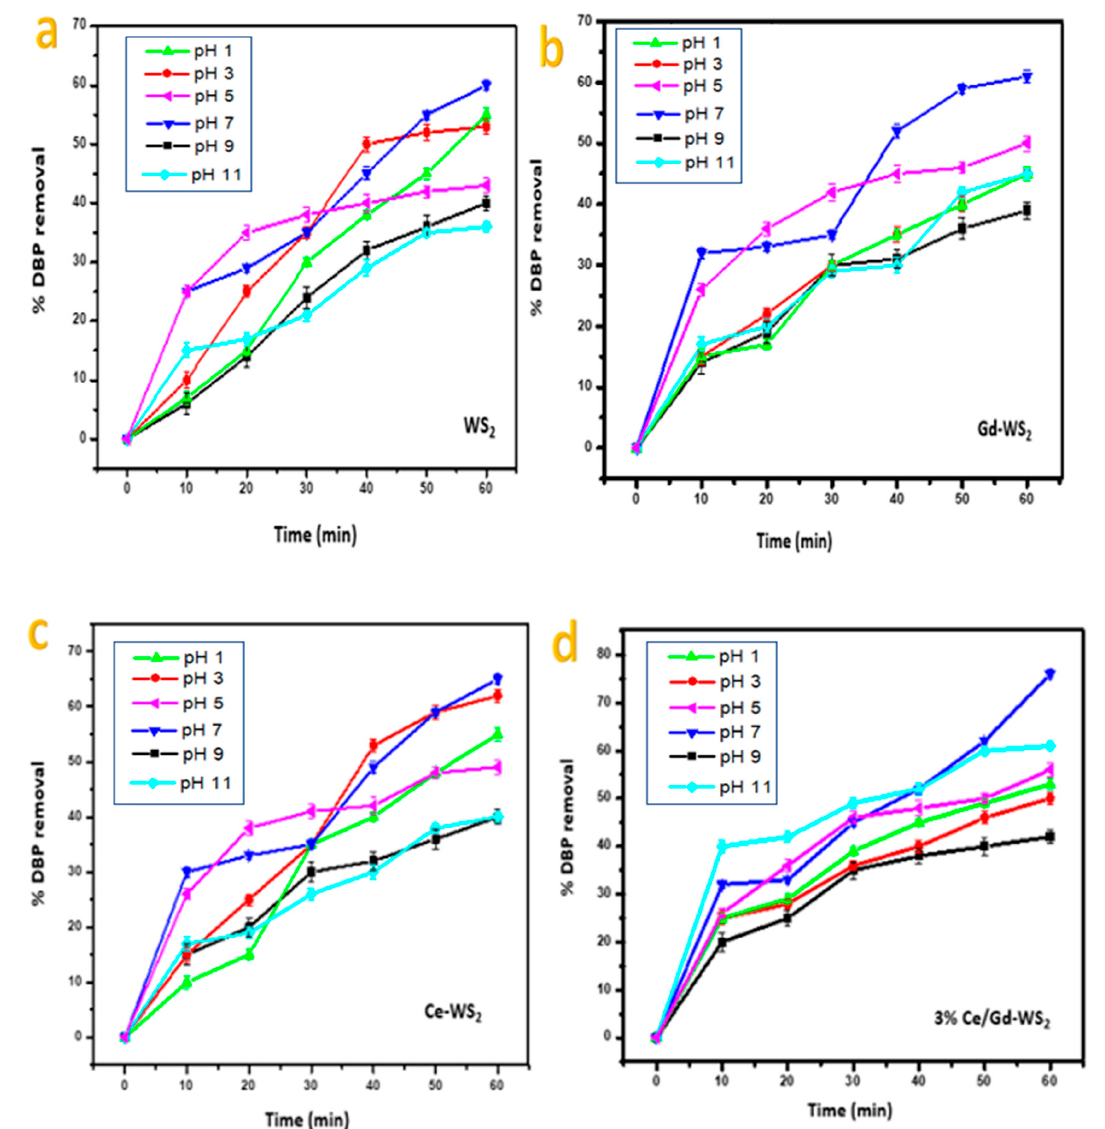
Figure 2. The effect of pH effect on the photodegradation of DBP using ( a )WS 2 , ( b ) Gd-WS 2 , ( c ) Ce-WS 2 and ( d ) 3% Ce/Gd-WS 2 .